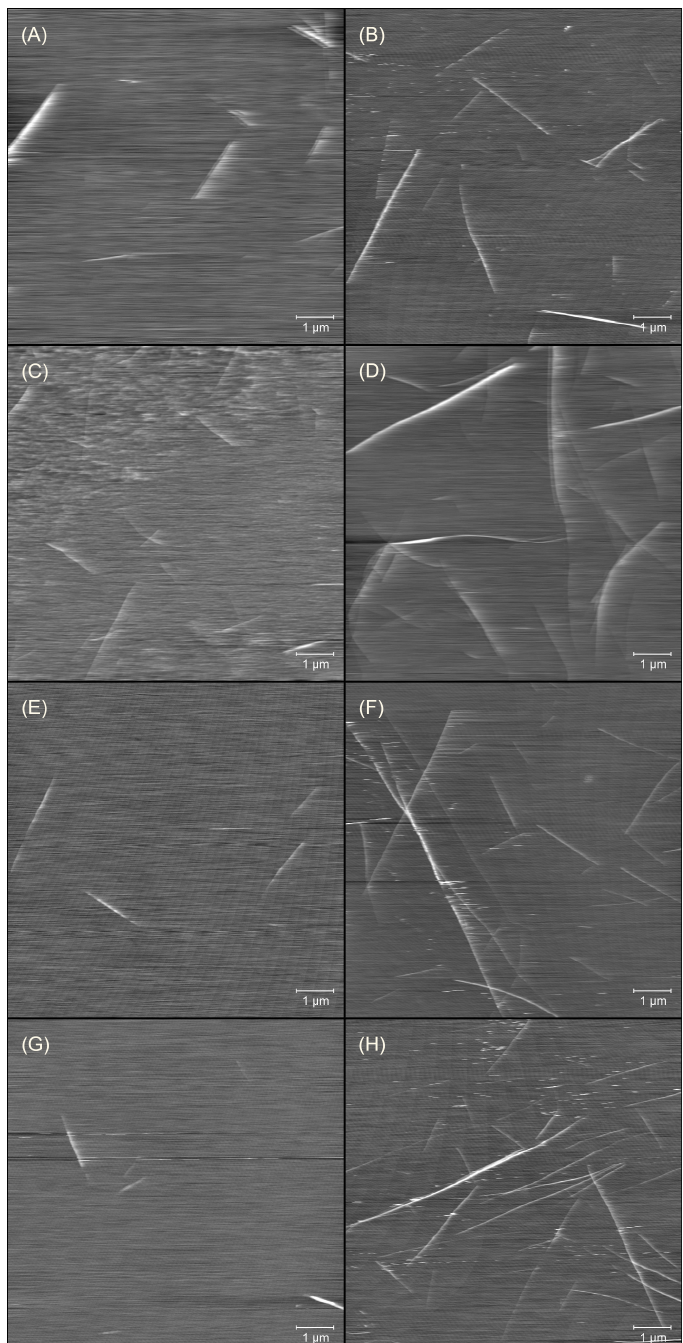
Figure 2. The atomic force microscopy scans for the samples of K-peptide in freshly prepared solutions (left column) and in the samples incubated at 37 ◦ C for 14 days (right column). The peptide was dissolved in: ( A , B ) water; ( C , D ) acetate buffer, pH = 4, without additives; ( E , F ) acetate buffer with dimethyl sulfoxide and ( G , H ) acetate buffer with